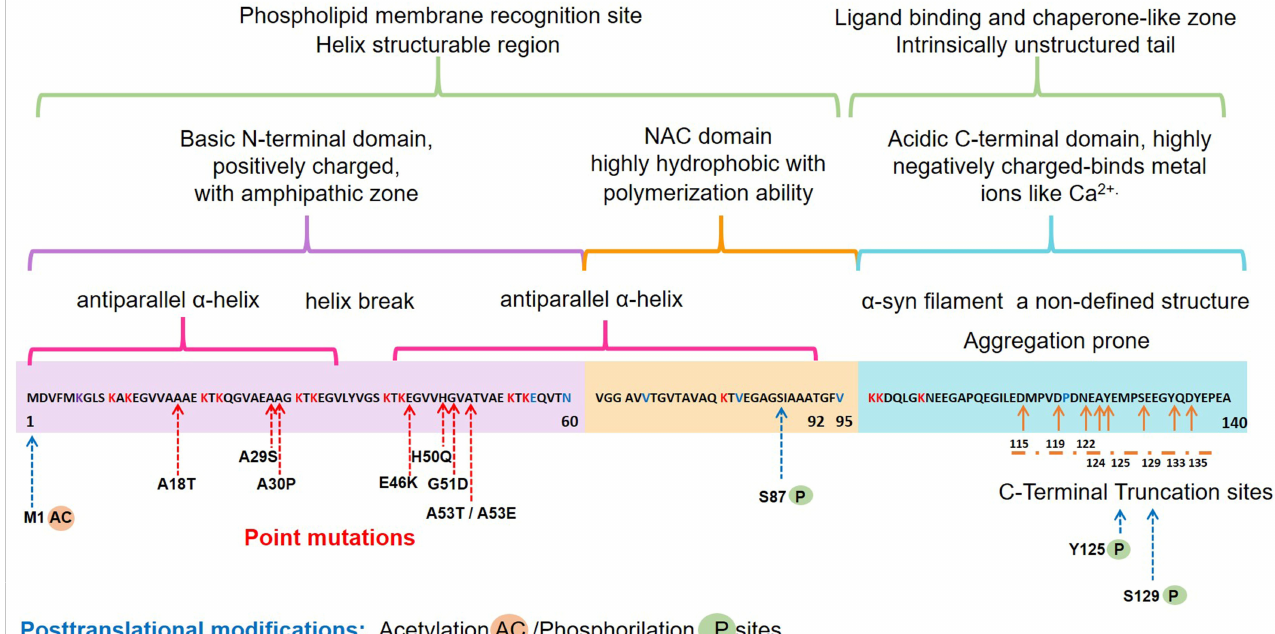
Figure 1. Schematic representation of the native α -syn monomeric structure, highlighting features linked to its biochemical function and dysfunction. Abbreviation: NAC, non-amyloid β